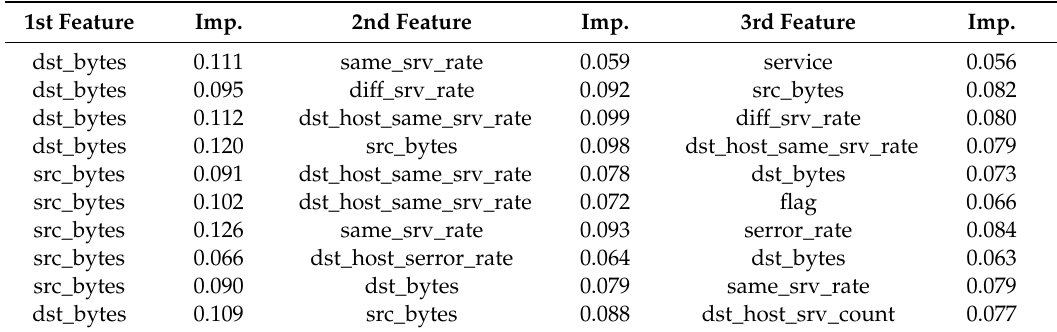
Table 1. The three most important features and their importance—NSL-KDD dataset, 10 runs. Each row contains the three most important features from a single run with their respective importance values for the built-in method.